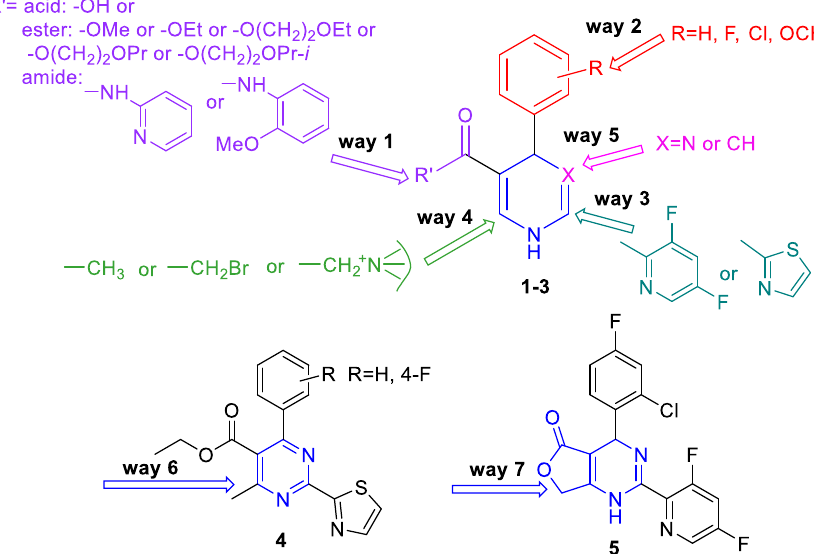
Figure 2. Structural diversifications of heteroaryldihydropyrimidines.